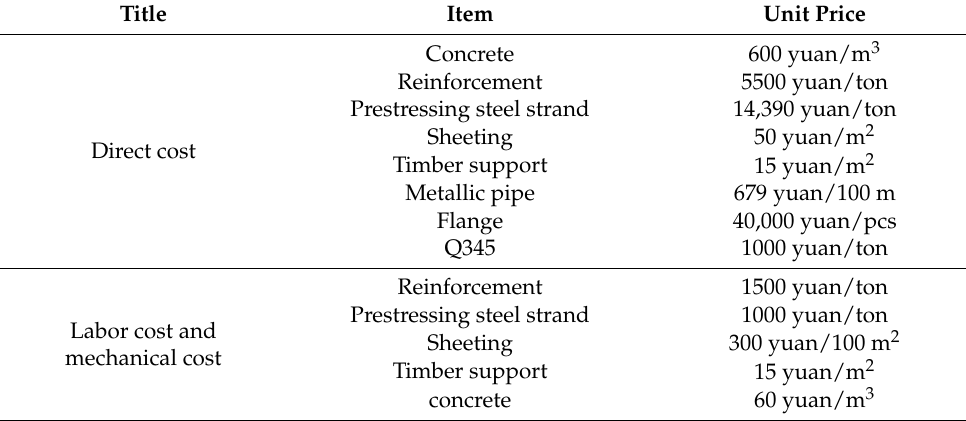
Table 2. The comprehensive cost of